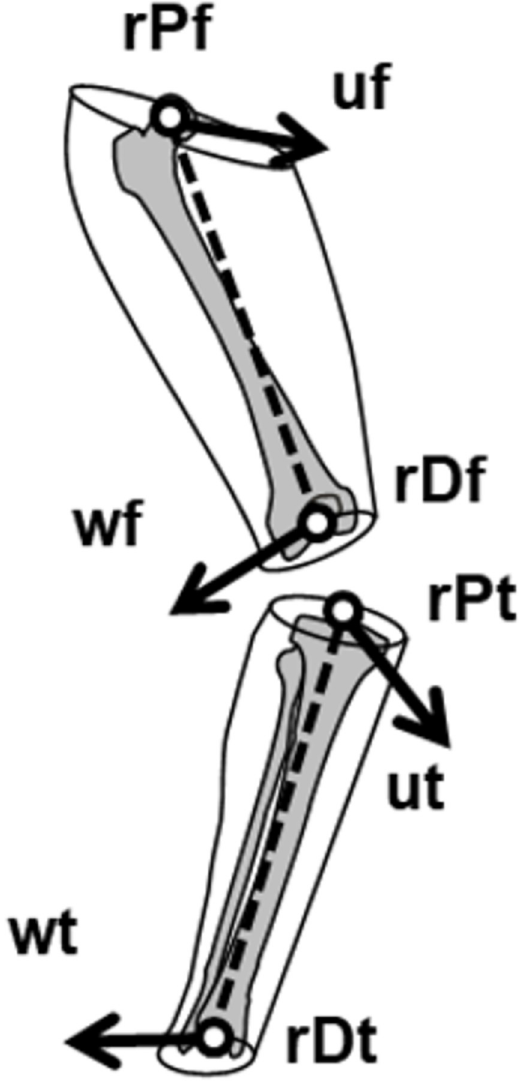
Fig 1. Local coordinate systems of the femur and